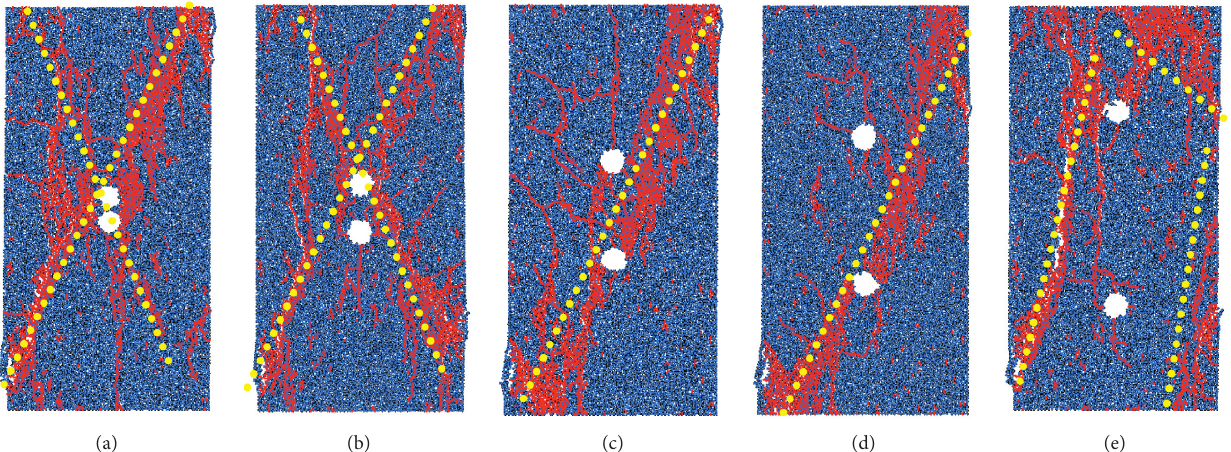
Figure 21: Failure modes of samples with different boreholes spacing. The S of (a), (b), (c), (d), and (e) are 1 D , 2 D , 4 D , 6 D, and 8 D , respectively.